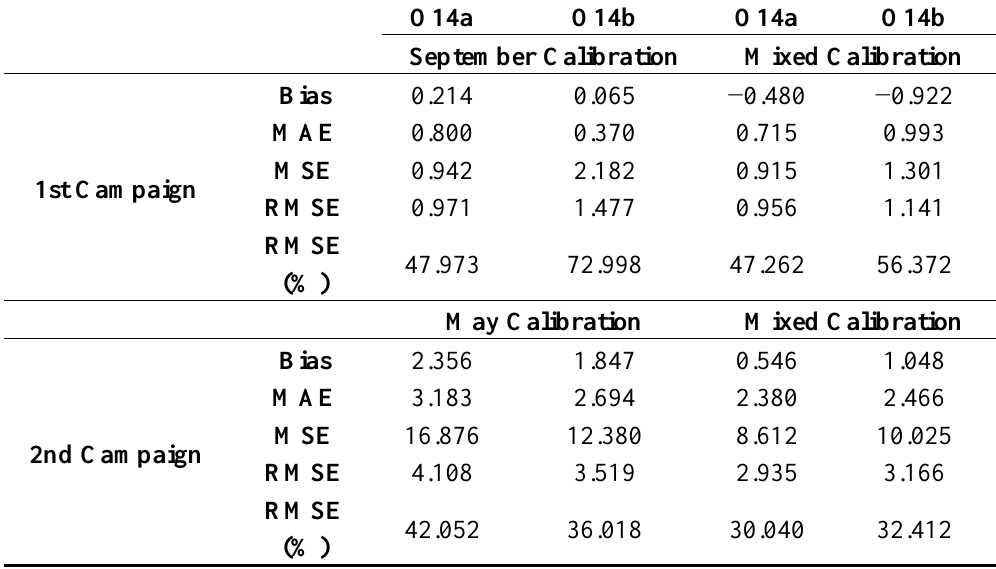
Table 5. Error results for the two campaigns and three calibrations (shaded areas represent the lowest